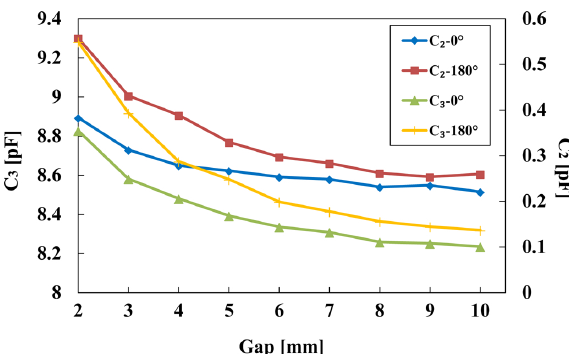
Figure 18. Calculated frequency di ff erence ( f 2 - f 1 ) from angular frequency pulling measurements (gap: 3 mm, 25 ◦ C).